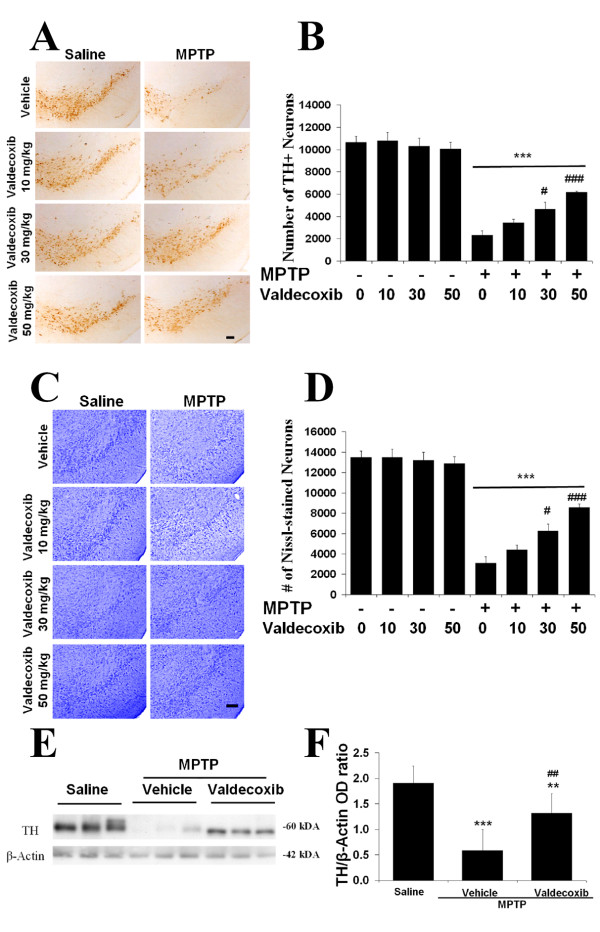
TH-positive neurons are more resistant to MPTP in mice treated with a selective COX-2 inhibitor (valdecoxib). A: Photomicrographs of representative SNpc sections stained with an antibody against TH. The SNpc tissues were collected 14 days post-MPTP injection. The MPTP (4 × 15 mg/kg, 1.5 hr interval, i.p.)-treated mice have fewer TH-positive neurons compared to the saline groups. However, valdecoxib treatment reduced the neuronal loss, especially at a higher dose (30 or 50 mg/kg daily). B: MPTP administration led to significant loss of TH-positive neurons numbers by 78 percent for vehicle and by only about 68, 56, and 42 percent for 10, 30 and 50 mg/kg valdecoxib-treated mice, respectively. Among the MPTP-injected mice, the valdecoxib-treated mice had 10 to 32 percent more TH-positive neurons than the vehicle-treated mice. Nissl stain shows similar trends (C&D). E: Inhibition of COX-2 reduced the MPTP-induced loss of the striatal TH immunoreactivity. F: After MPTP treatment, the vehicle-treated mice had significantly reduced TH immunoreactivity compared to the saline-treated mice (***p < 0.001). Among the MPTP-injected mice, the valdecoxib (30 mg/kg daily)-treated mice had at least 30% higher TH immunoreactivity than the vehicle-treated mice. Data are means ± SEM for six to eight mice per group, **p < 0.01 and ***p < 0.001 compared to saline+vehicle group; #p < 0.05, ##p < 0.01 and ###p < 0.001 compared to MPTP+vehicle group, by ANOVA with subsequent Bonferroni for multiple comparisons. Scale bar, 100 μm.